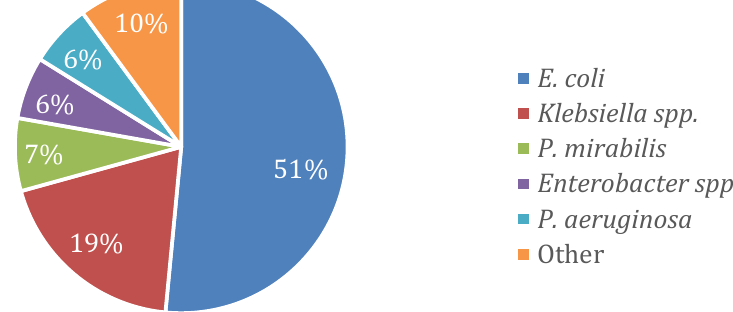
Figure 1. Microbiology of Gram-negative bloodstream